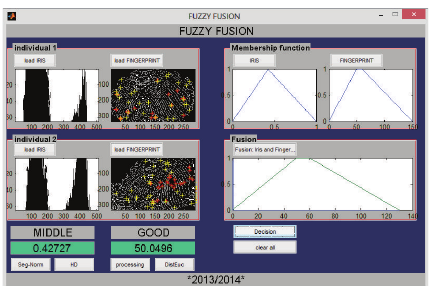
Figure 13: GUI showing the matching using the fusion by the fuzzy inference